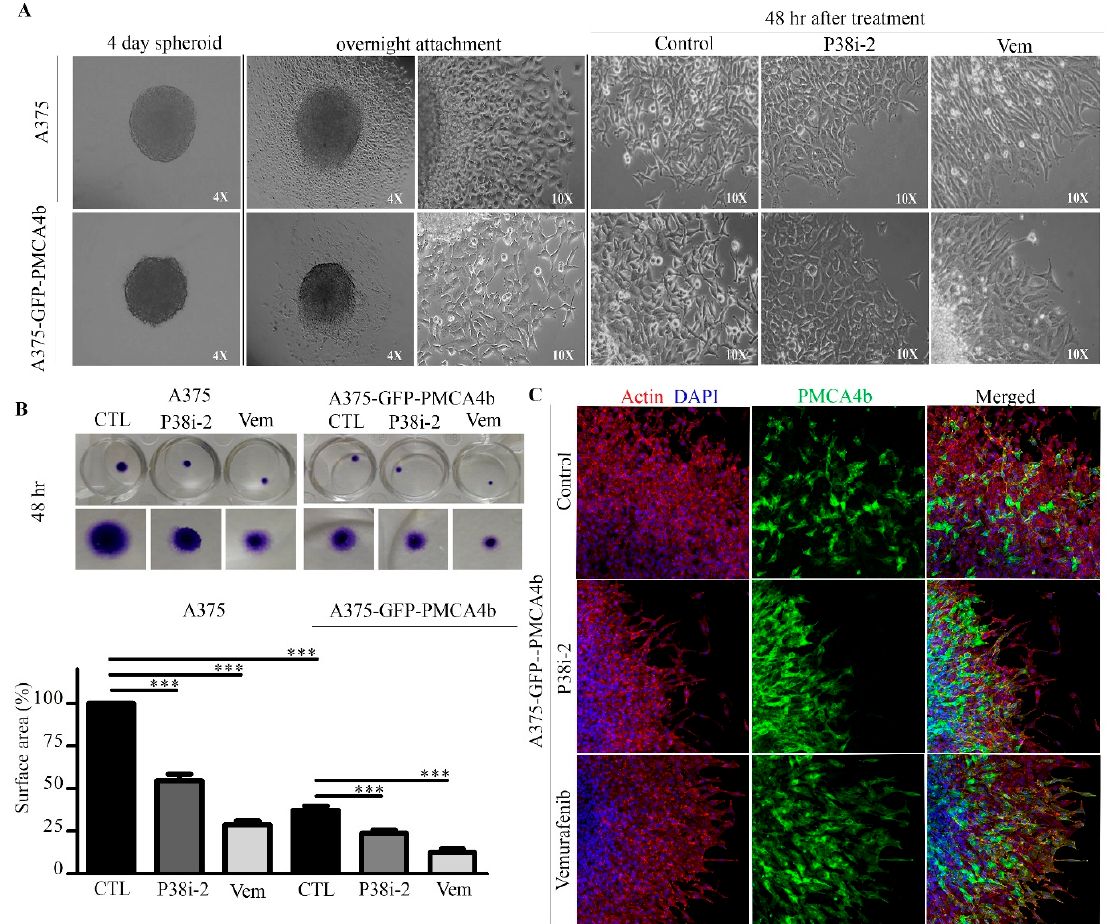
Figure 8. P38 inhibitor reduced metastatic activity (reversal of multicellular spheroids) of A375 cells in vitro. ( A ) A375 and A375-GFP-PMCA4b cells were seeded to form spheroids as previously described. After four days the spheroids were transferred to a 24-well plate and after overnight attachment they were treated with 0.5 µ M vemurafenib or 10 µ M SB202190 for 48 h. Images were taken using light microscope, 4 × and 10 × magnification. ( B ) Cells were fixed and stained with 0.5% crystal violet. Pictures were taken and the surface area was measured using the ImageJ software v1.42q. The surface area was calculated relative to the control. Data are means ± SD of three independent experiments. ( C ) A375-GFP-PMCA4b spheroids were generated and treated in a similar way as above. Cells were fixed and immunostained with phalloidin-TRITC and DAPI. Pictures were taken using confocal microscopy, 10×. Scale bar, 20 µm.